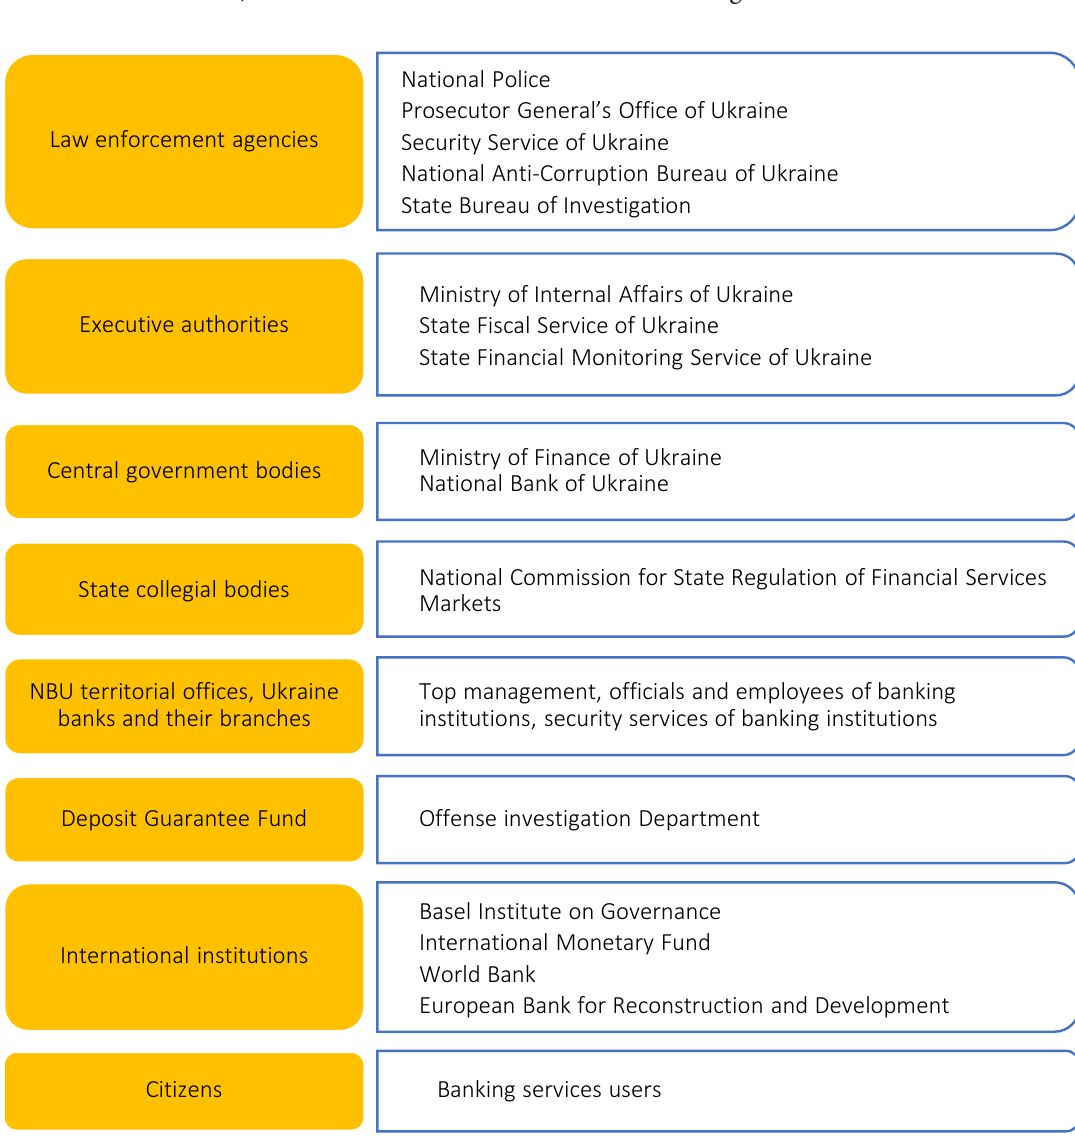
Figure 2 outlines entities engaged in combating crime in banking.